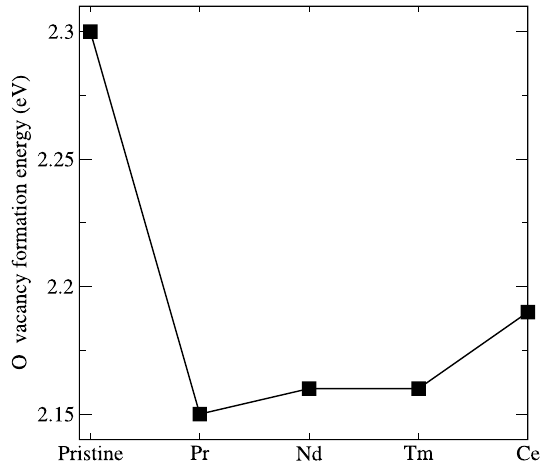
Figure 5. O vacancy formation energy of pristine and REE doped